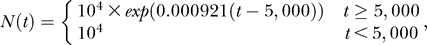
Examples of Simulated TrajectoriesTrajectories of simulated allele frequency under different selection models. For each selection model, 100 replicates are simulated and three trajectories corresponding to the 5%, 50%, and 95% quantiles of the trajectory length are plotted. The selection models are neutral (left top, s
1 = s
2 = 0), advantageous (right top, s
1 = 0.001 and s
2 = 0.002), deleterious (left bottom, s
1 = −0.001 and s
2 = −0.002) and a mixed-selection model (right bottom) in which the disease allele is advantageous before 2,000 generations ago (s
1 = 0.001 and s
2 = 0.002) and is under purifying selection in the recent 2,000 generations (s
1 = −0.001 and s
2 = −0.002). In all cases, the current allele frequency is 10%. The population size is
such that N(10,000) = 106. Note that one of the trajectories in the left bottom panel is longer than 20,000 generations and its allele frequency is more than 0.5 before generation 10,000.